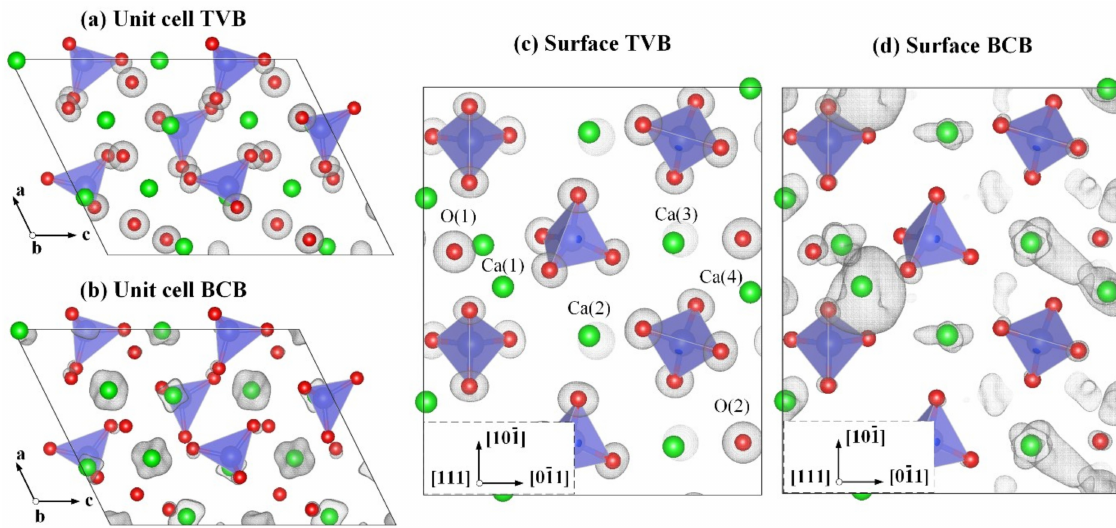
Figure 3. Band decomposed charge densities around the TVB and BCB, ρ ( r ) TVB and ρ ( r ) BCB , of M3-C 3 S structures for ( a ), ( b ) unit cell and ( c ), ( d ) surface